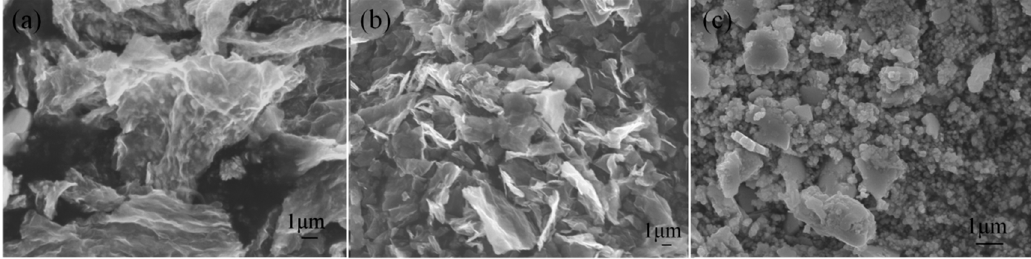
Figure 4. Scanning electron microscope (SEM) images of ( a ) SnS/NG, ( b ) SnS/G, and ( c ) SnS.